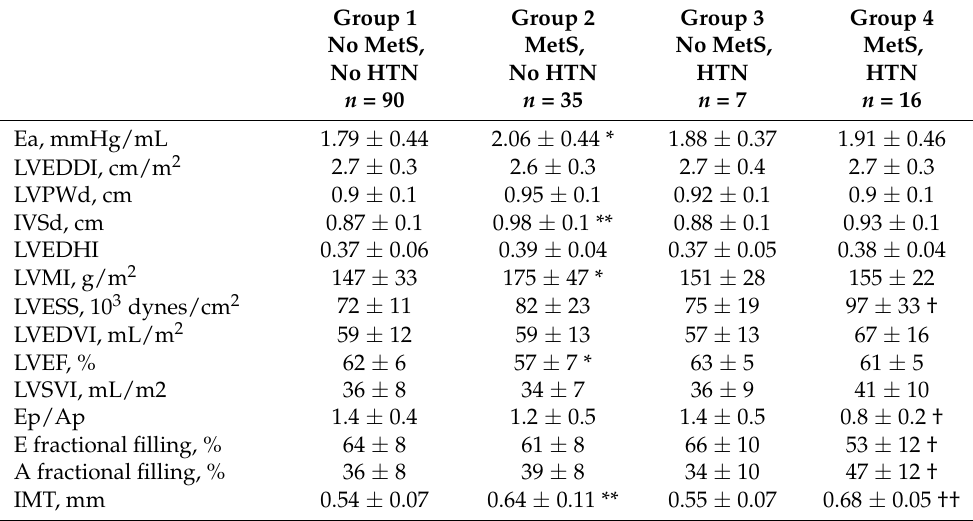
Table 4. Patient echocardiographic and vascular ultrasound variables in the four subgroups de- fined by the absence/presence of metabolic syndrome (no MetS and MetS, respectively) and ab- sence/presence of hypertension (no HTN and HTN,